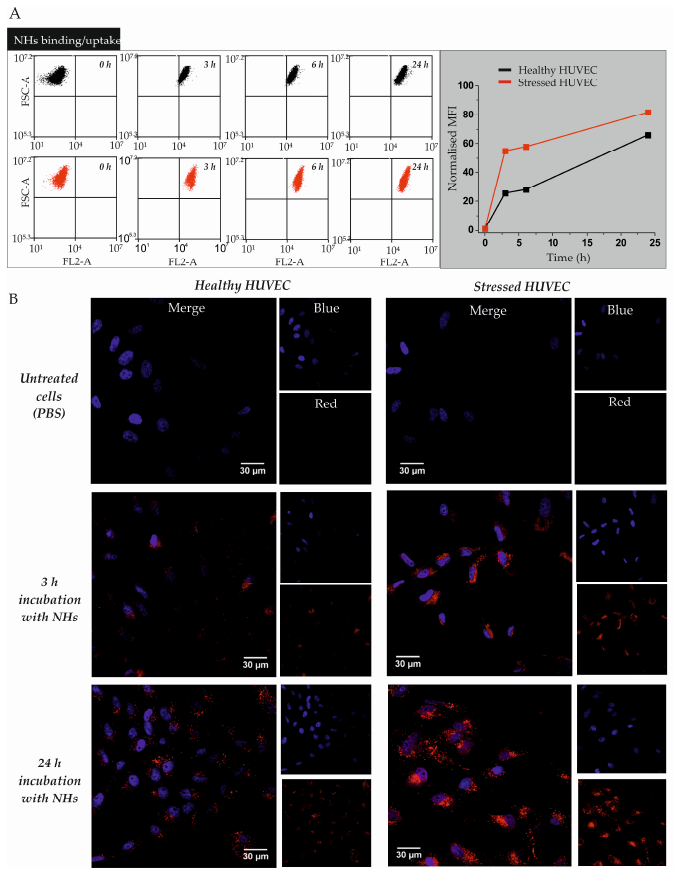
Figure 1. ( A ) Flow cytometry analysis of healthy or oxidatively stressed Human Umbilical Vein Endothelial Cells (HUVECs) incubated with rhodamine B isothiocyanate-nanohydrogels (Rhod-NHs). Cells were cultured in complete Dulbecco’s Modified Eagle Medium (DMEM) for 48 h and then incubated from 3 to 24 h with 100 µ g mL − 1 Rhod-NHs. ( B ) Confocal micro-graphs (scale bars: 30 µ m) of healthy (left) or oxidatively stressed (right) HUVECs, incubated with 100 µ g mL − 1 Rhod-NHs for 3 or 24 h. Blue colour refers to nuclei incubated with 4 (cid:48) ,6-diamidino-2-phenylindole (DAPI), whilst red colour refers to Rhod-NHs. Untreated cells received